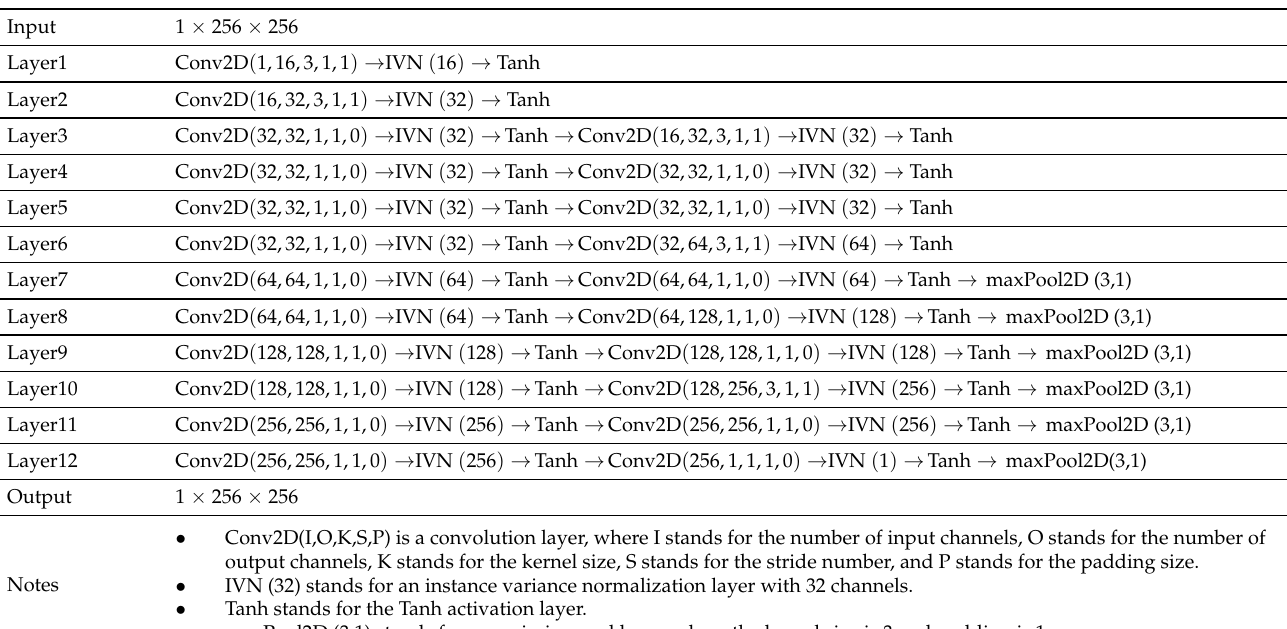
Table 1. Details of each layer of the Table 1. D etails of each layer of the generator. Table 1. D etails of each layer of the generator.